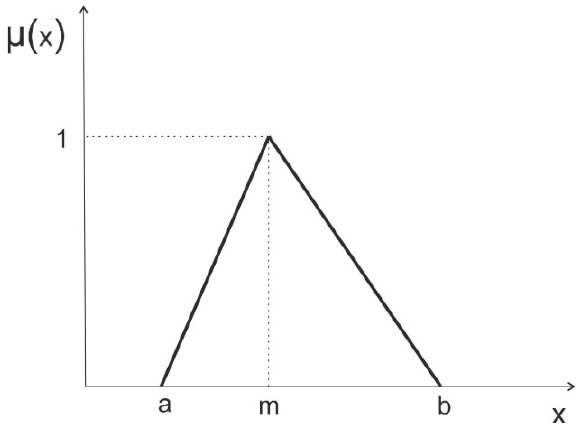
Figure 3: Graphical presentation of a triangular fuzzy